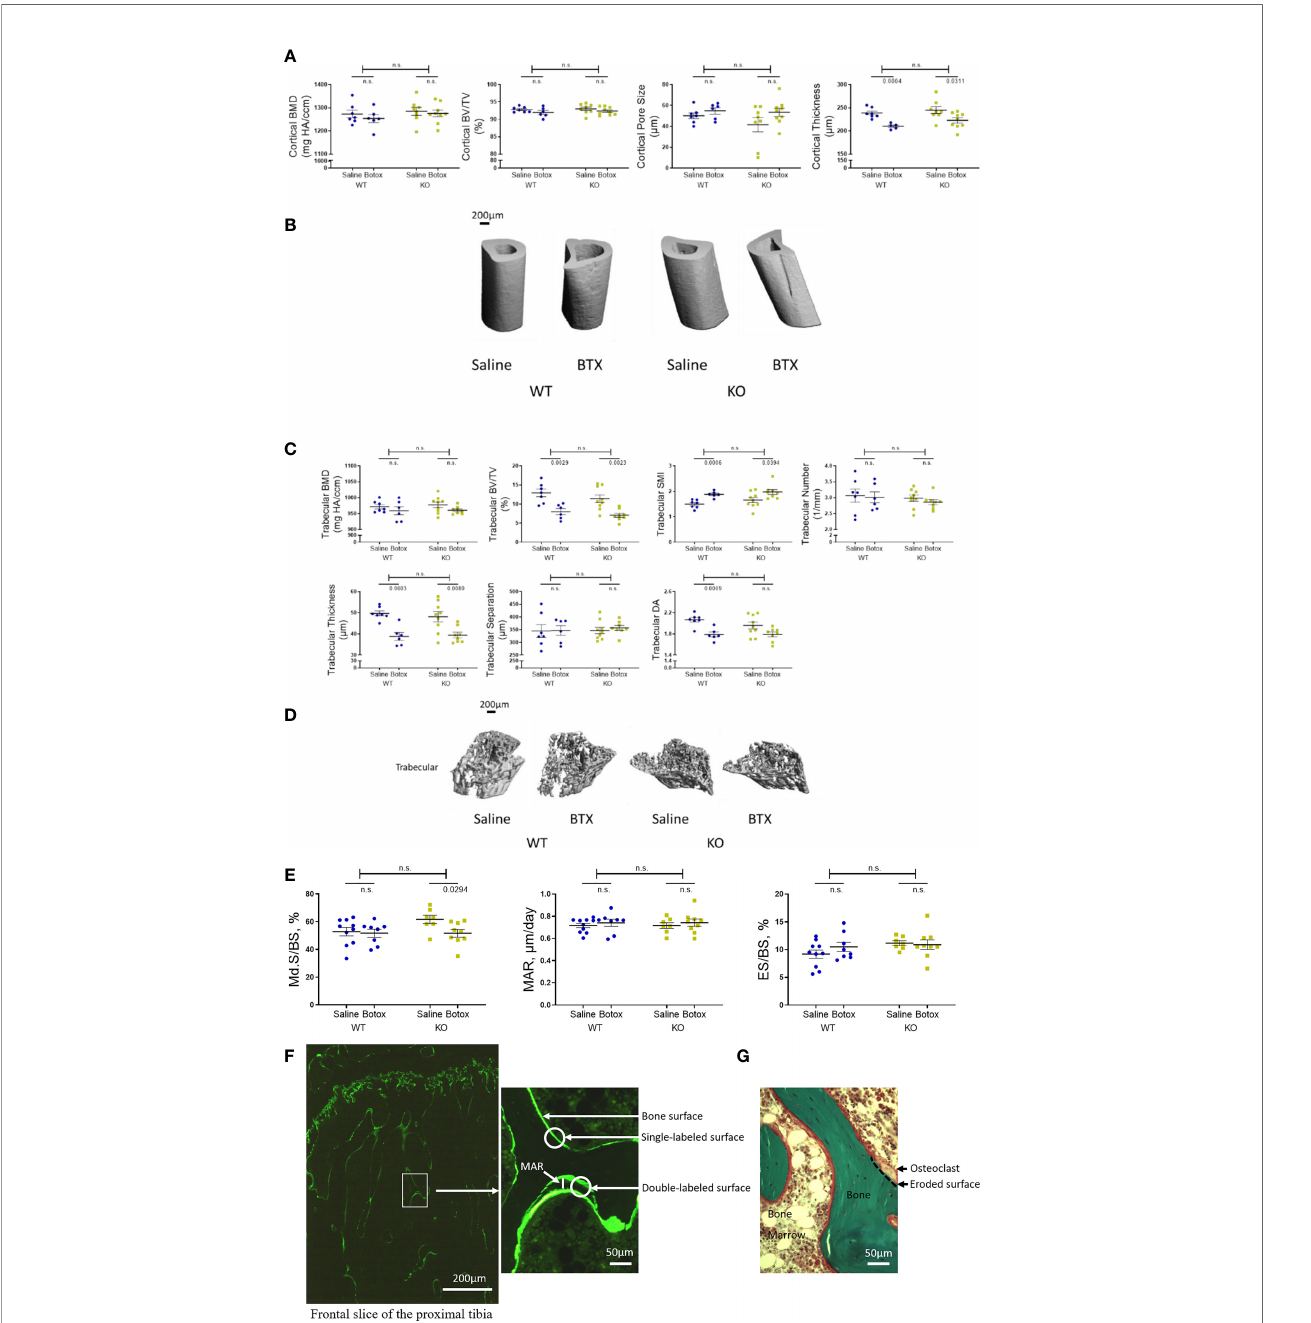
FIGURE 2 | Tibial microstructural parameters determined after the unloading phase in both WT and KO at 3- weeks after BTX- induced muscle paralysis. (A) cortical bone mineral density (BMD, mg HA/ccm), bone volume (BV/TV, %), pore size (µm) and thickness (µm), and (B) representative images to show the changes in cortical indices. (C) Trabecular BMD (mg HA/ccm), BV/TV (%), structure model index (SMI, -), trabecular number (1/mm), trabecular thickness (µm), trabecular separation (µm), and trabecular degree of anisotropy (DA, -) and (D) representative images to show the changes in trabecular indices. (E) Histomorphometric indices to show to Md.S/ BS (mineralized surfaces as percentage of bone surface), MAR (mineral apposition rate in µm/day) and ES/BS (eroded surface as percentage of bone surface) in vivo in both WT and KO mice at 3- weeks after BTX- induced muscle paralysis. (F) Illustrations of calcein labeled and (G) Goldner ’ s trichrome stained slices to quantify the histomorphometric indices. Statistical signi fi cance was tested with either Student ’ s unpaired t-test/Mann-Whitney test (effect of KO) or, 2-way ANOVA (effect of BTX and KO) with Tukey ’ s test for multiple comparisons. n.s., no signi fi cance. Data shows mean ± SEM of n = 6-7 mice (WT) and 8-9 mice (KO) for Micro-CT and, n= 8- 10 mice (WT) and 7-9 mice (KO) for